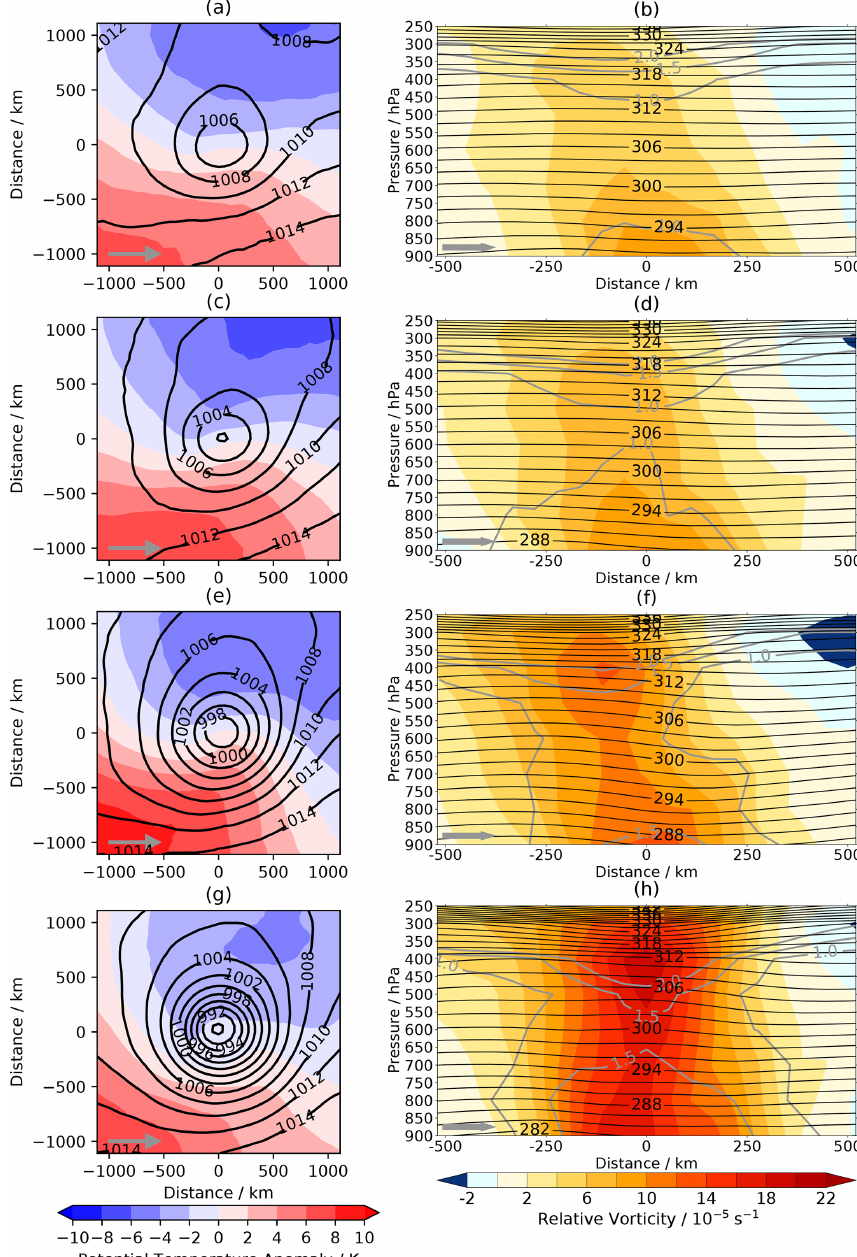
Figure 10. As for Fig. 9 but for the 200 most intense unmatched Arctic cyclones.